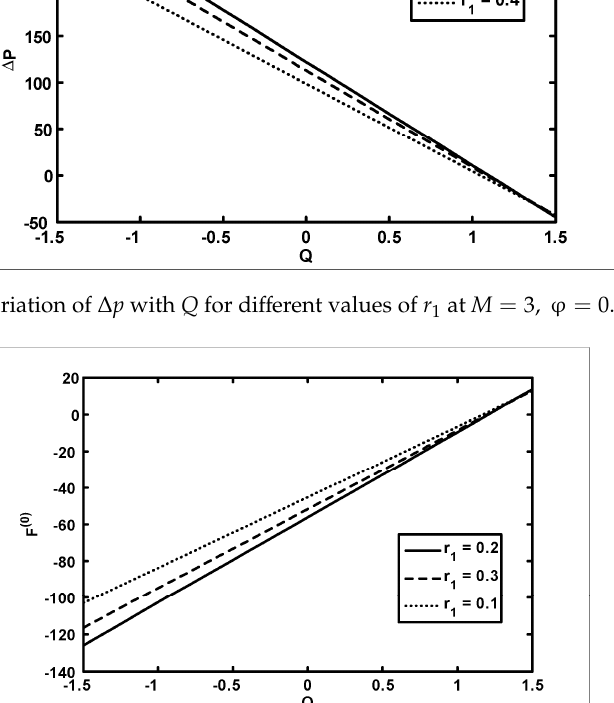
Figure 11. The variation of friction force F ( 0 ) (outer tube) with Q for di ff erent values of r 1 at ϕ = 0.4, M = 3, when µ = 1 .